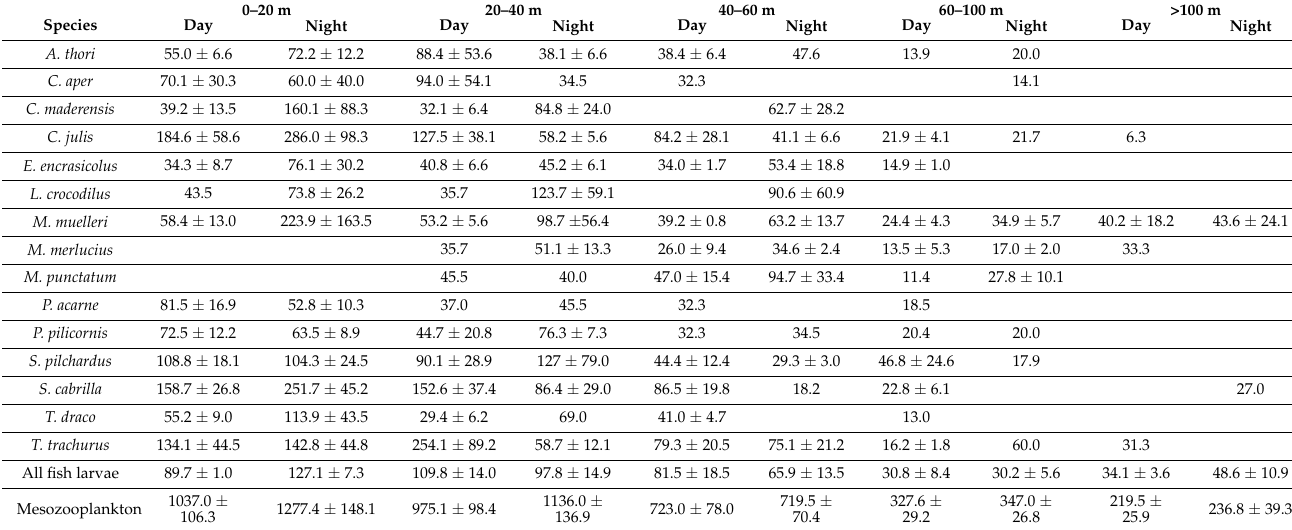
Table 3. Mean density (standard error) of the larval fish species (larvae · 1000 m − 3 ), mesozooplankton (individuals · m − 3 ), and all fish larvae (larvae · 1000 m − 3 ) in each depth stratum and period (day and night).